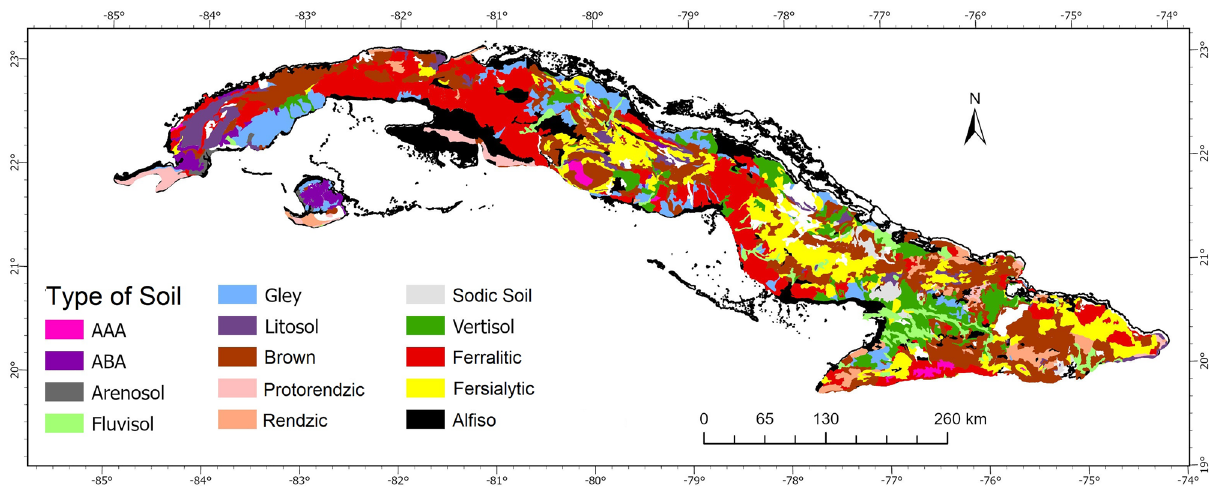
Fig. 20 Map of types of soil in Cuba [50]. AAA: Alitic High Clay Activity, ABA: Alitic Low Clay